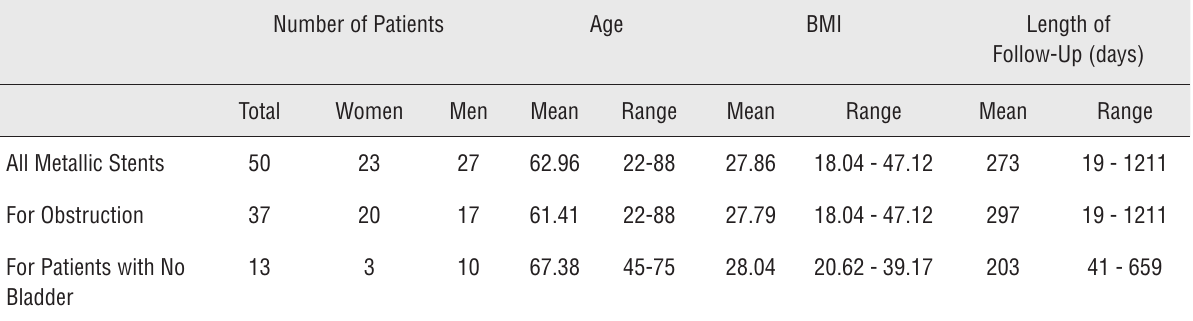
Table 2 - Patient Characteristics.